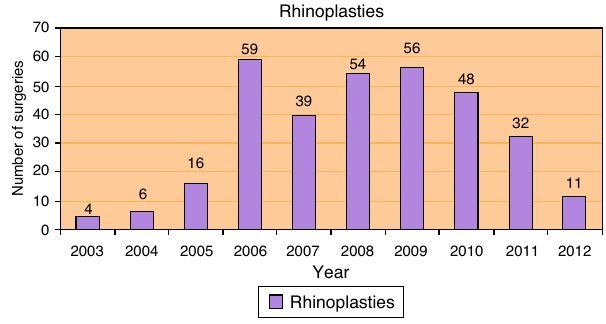
Rhinoplasties performed per year, from January of 2003 to August of